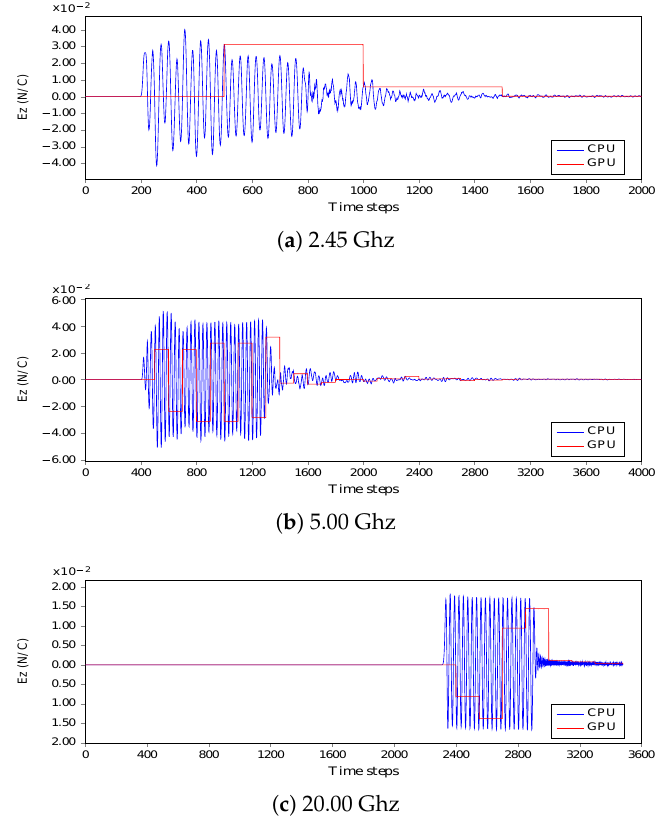
Figure 19. Comparison of the solution along the time obtained in the GPU vs. CPU in viewer 3. Very similar solutions were obtained for all other viewers. The solution can only be compared when the information is transferred to the